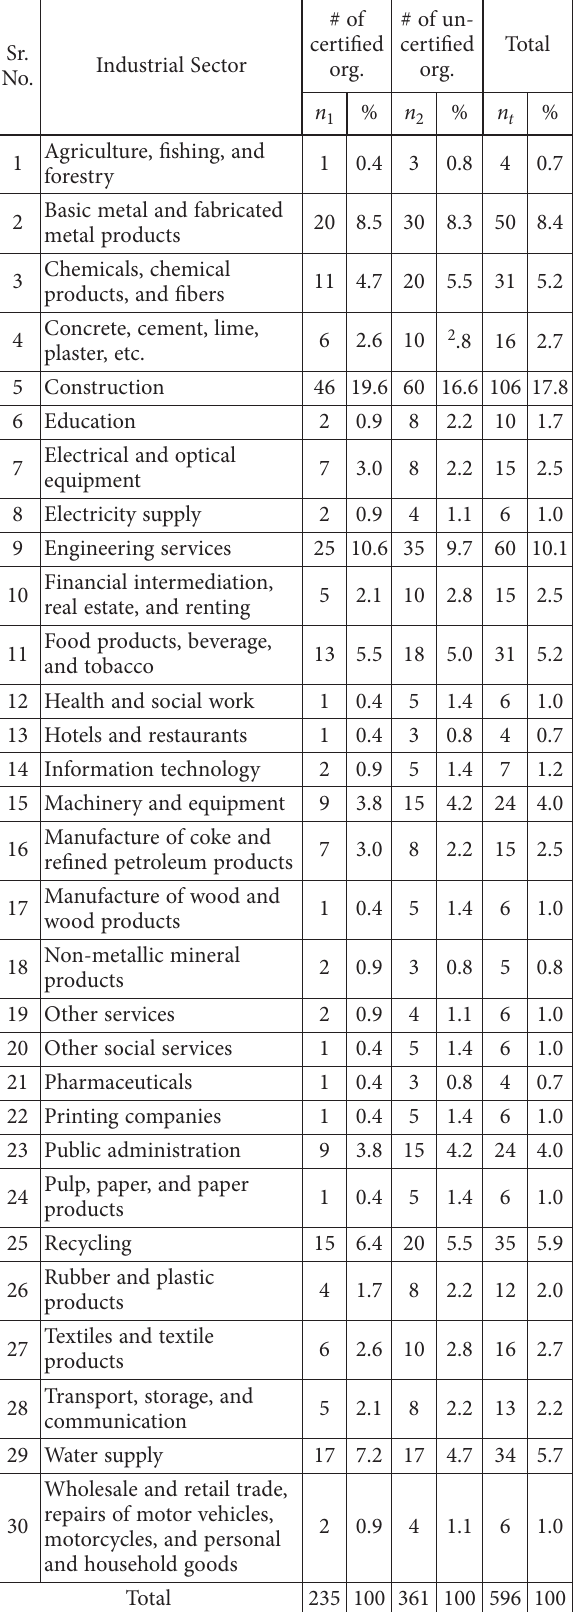
Table 2. Response rates of certified and uncertified organizations and their industrial